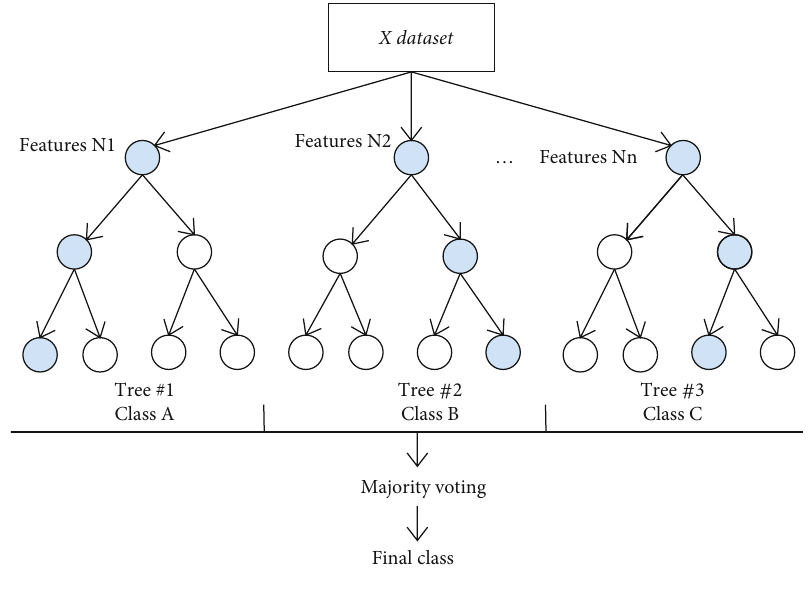
Figure 3: Representation of random forest classi fi er.